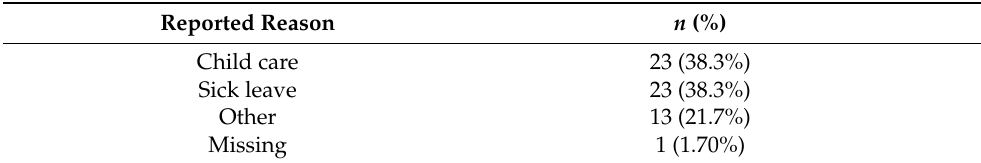
Table 1. Reasons of not working during lockdown ( n =